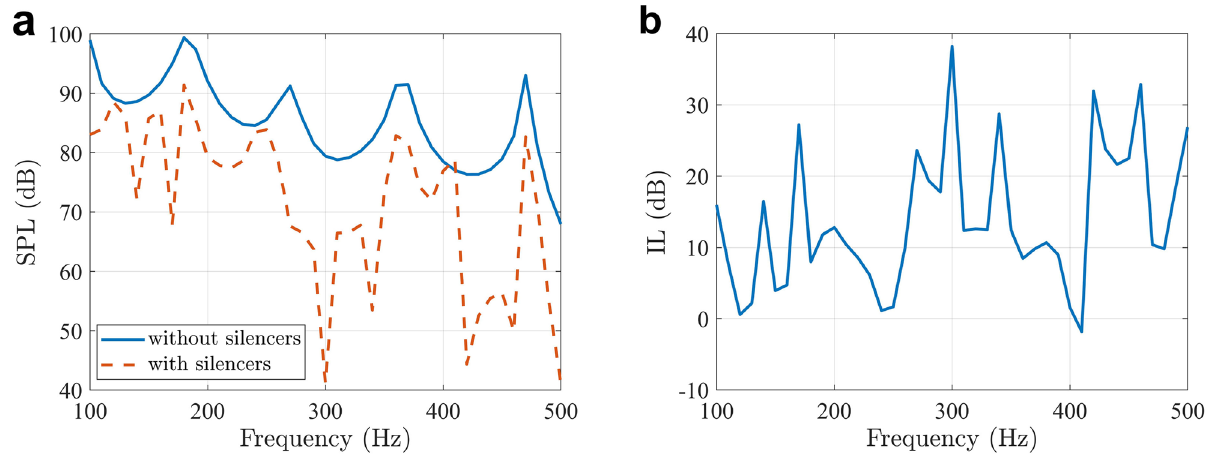
Figure 3. (a) The SPLs at the evaluation point with and without the silencers in numerical simulations. (b) The insertion loss caused by the silencers.